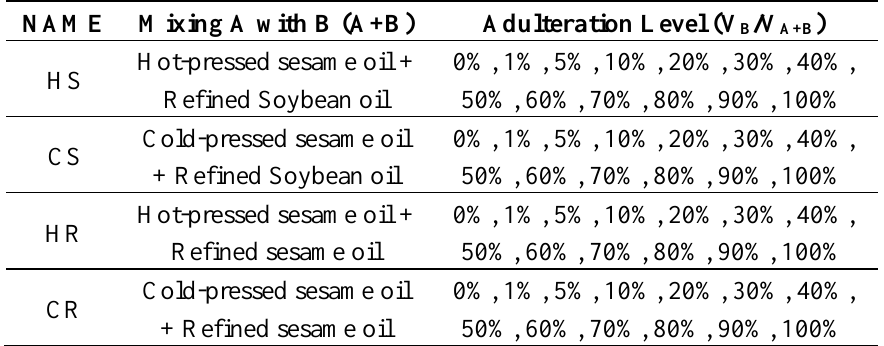
Table 2. Adulterated sesame oil